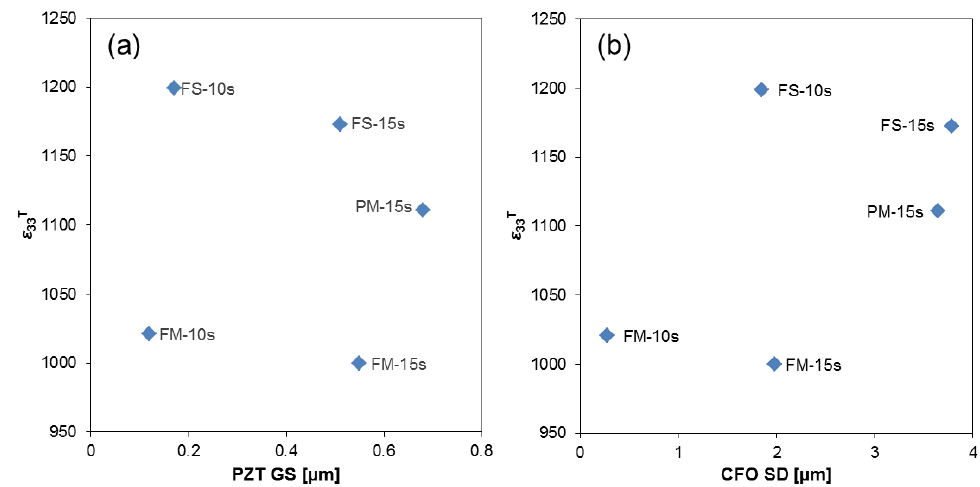
Figure 5. ( a ) Permittivity as a function of PZT average grain size. ( b ) Permittivity versus Sauter’s diameter of the CFO particles.